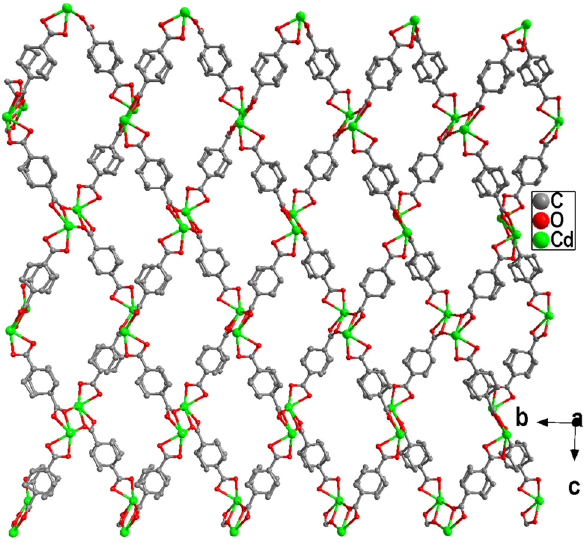
Figure 2: View of the 2D layer structure of 1 constructed by the 1,4 -